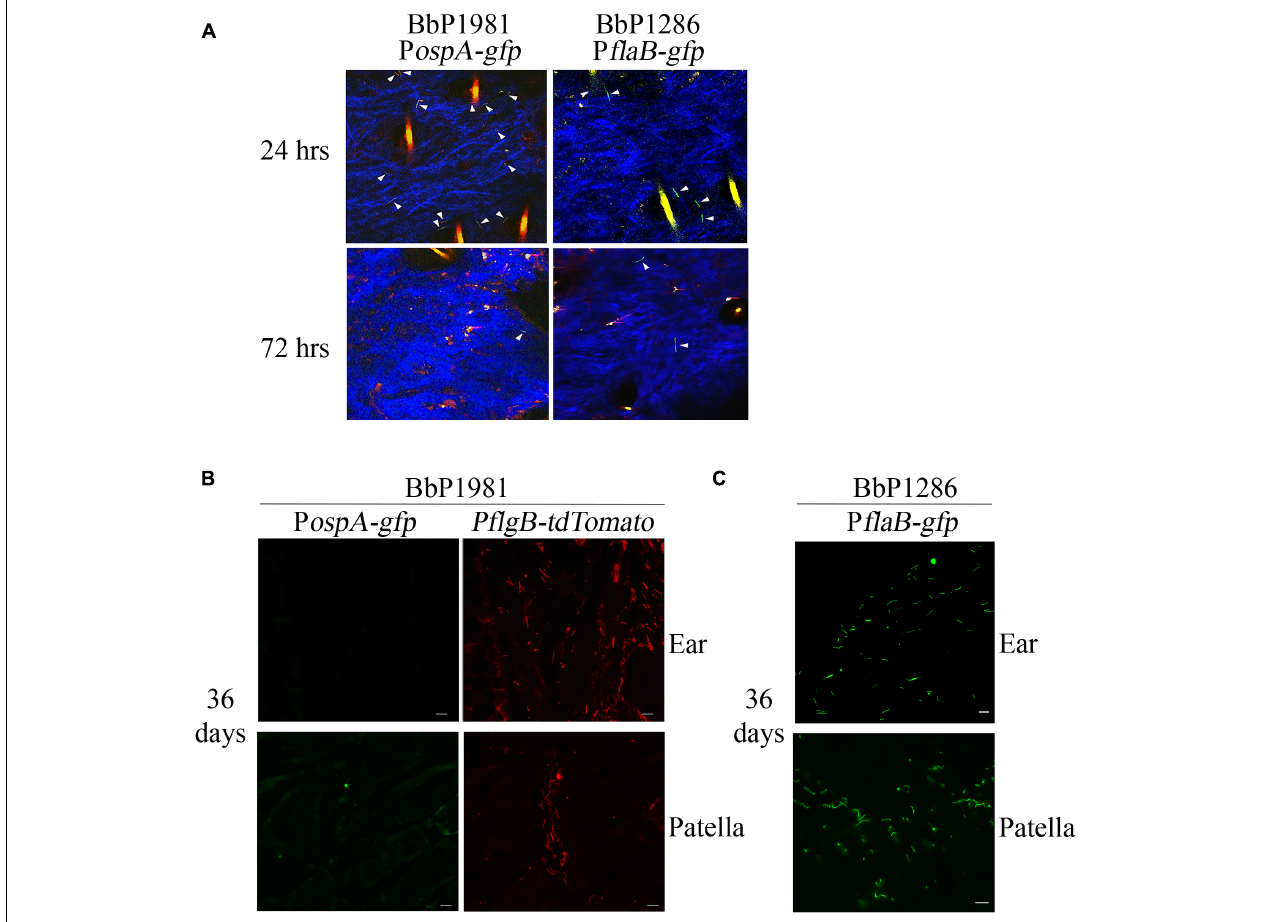
FIGURE 3 | Repression regulation of ospA in mice is not complete until > 72 h after syringe-inoculation and continues throughout the mammalian phase. (A) Representative composite two-photon microscopy images of ear tissues from Myd88 − / − mice 24 and 72 h after needle-inoculation with either P ospA-gfp (BbP1981) or P flaB-gfp (BbP1286). Arrowheads indicate intact GFP+ spirochetes. Three-dimensional z -stack images were rendered using Volocity software from images of sequential x, y planes taken at different levels. Hair follicles and dermal collagen fibers fluoresce yellow-orange and blue, respectively, due to second-harmonic generation. A minimum of 20 fields per tissues were examined. Representative images for day 8 and 13 are shown in Supplementary Figure 4A . (B,C) Representative epifluorescence images of 7 µ m cryosections of ear and patella collected from Myd88 − / − mice 36 days post-infection (p.i.) by needle with BbP1981 to detect P ospA-gfp and P flgB-tdTomato (B) or BbP1286 to detect P flaB-gfp (C) . Scale bar, 20 µ